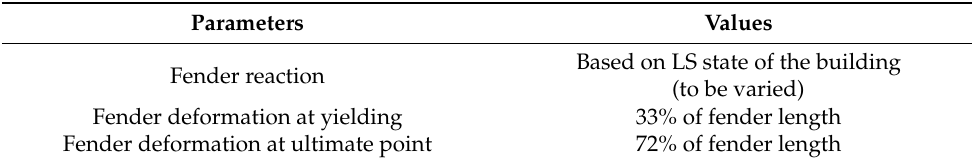
Figure 7. Load-deformation curve of a typical marine fender. Table 2. Parameters for the fender structure.